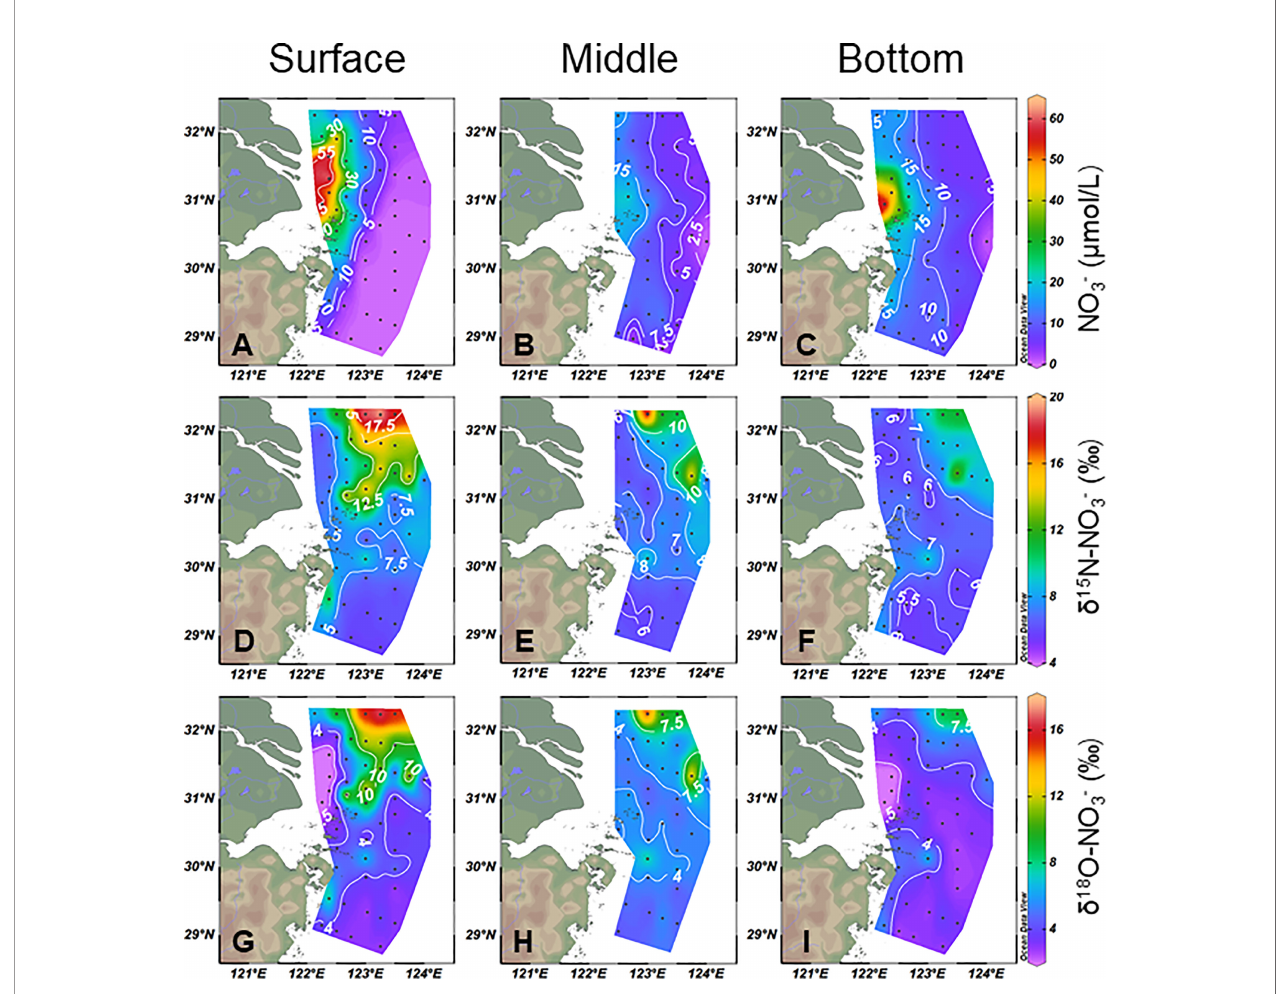
FIGURE 3 | Horizontal NO − 3 (A – C) , d 15 N − NO − 3 (D – F) , and d 18 N − NO − 3 (G – I) distributions at the surface, middle, and bottom water in the study